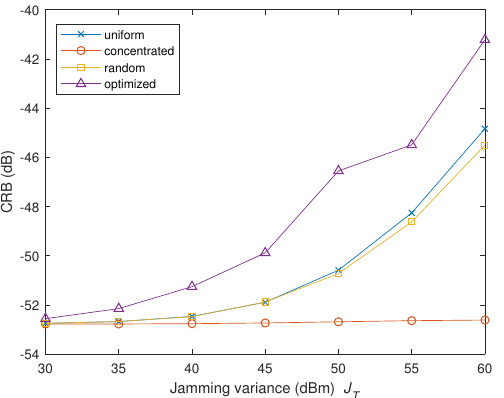
Figure 6. CRB of x versus the total jamming power J T in the second